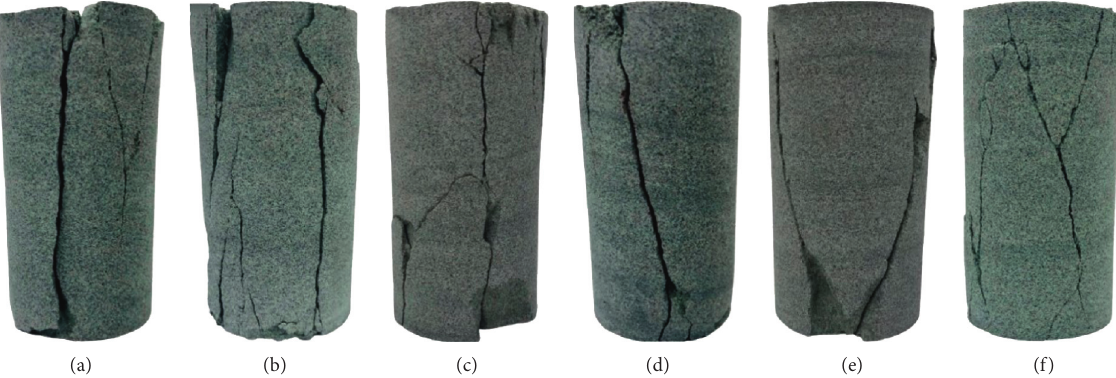
Figure 10: Failure form of sandstone with different water contents. (a) ω � 0%. (b) ω � 0.57%. (c) ω � 1.06%. (d) ω � 1.82%. (e) ω � 2.43. (f) ω �